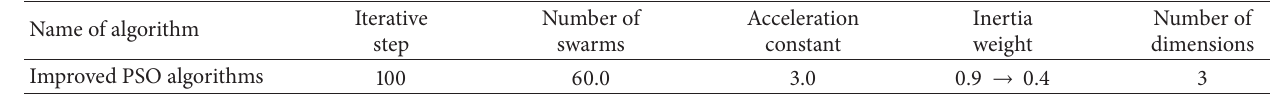
Table 3: Parameters of correction